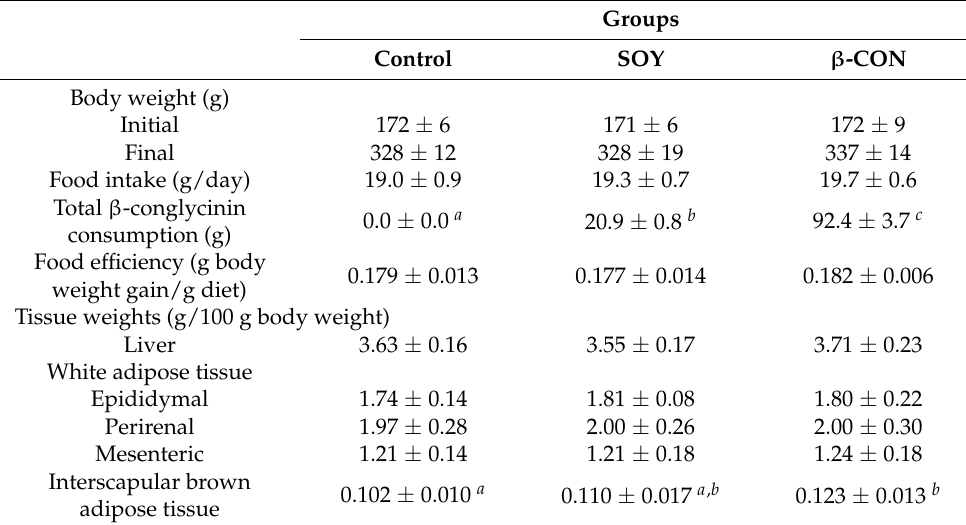
Table 1. Effect of dietary β -conglycinin on growth parameters in SHR.